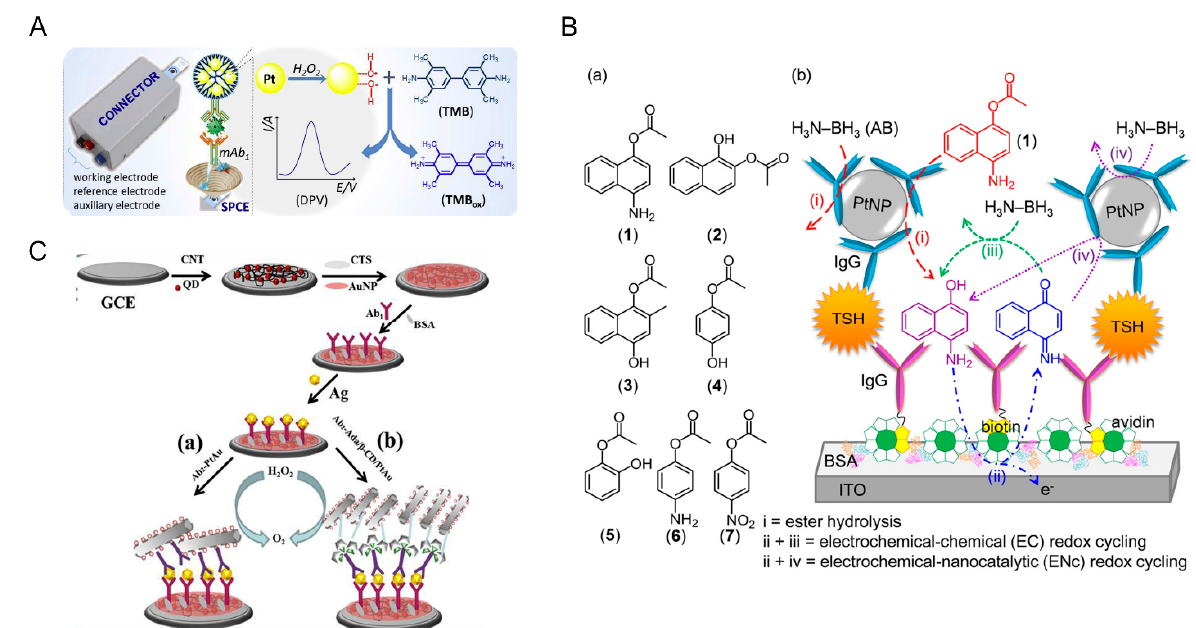
Figure 4. ( A ) Schematic diagram of the construction of electrochemical immunosensing platform by using PtDEN for lung cancer biomarker detection [62]. Reprinted with permission from ref [62].